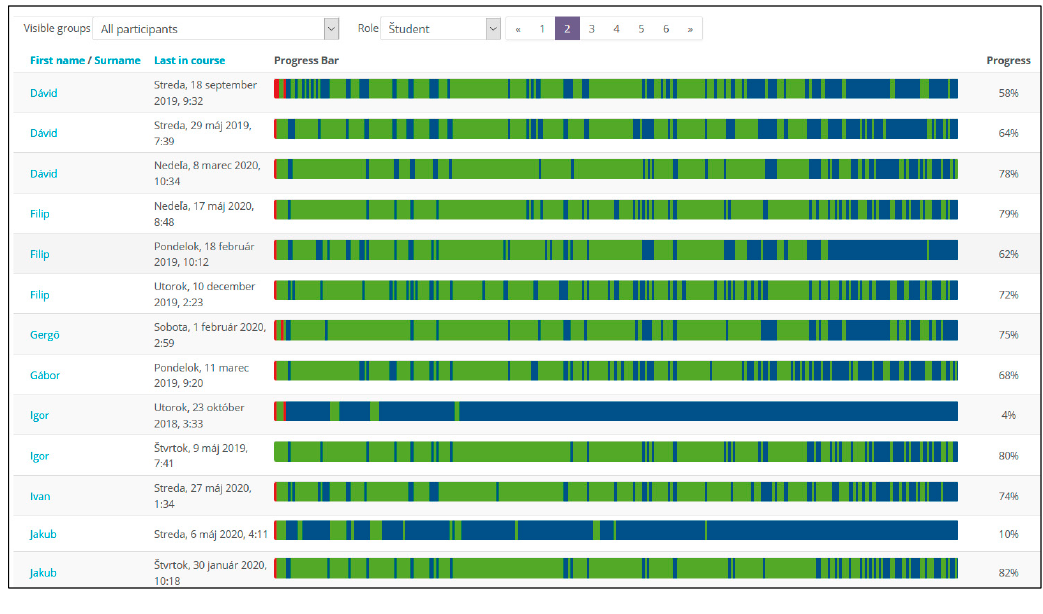
Figure 1. An example of the visualisation of the progress monitoring in one of the LMS Moodle courses used in the research. It is possible to identify users with low activity in course.